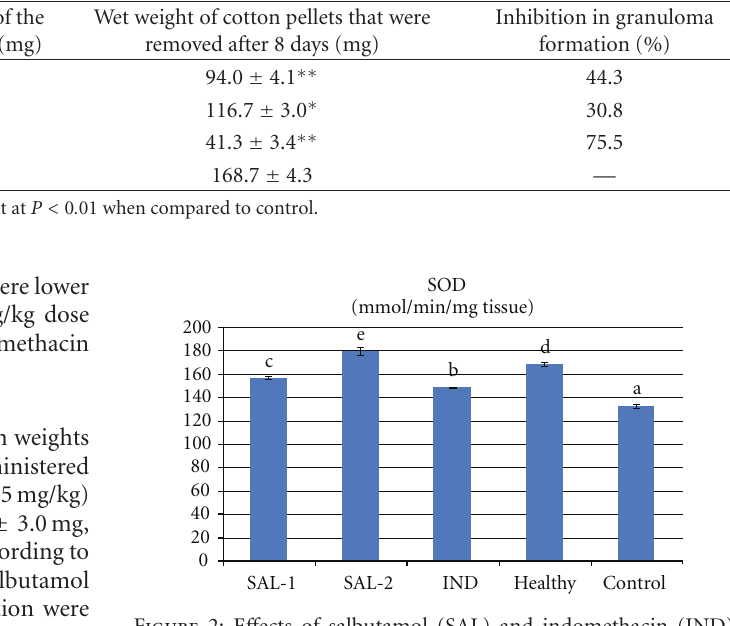
Figure 2: E ff ects of salbutamol (SAL) and indomethacin (IND) on superoxide dismutase (SOD) activity in carrageenan-injected paw tissues. Means in the same column by the same letter are not significantly di ff erent and the means in the same column by di ff erent letters demonstrate significant di ff erences between the groups according to the Duncan test ( α = 0 . 05). In the above figure, all columns have di ff erent letters. This demonstrates that values in these columns are statistically di ff erent from each